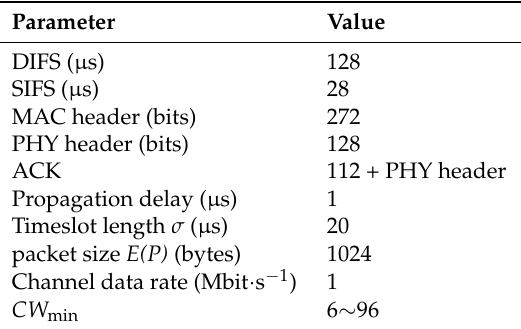
Table 3. System channel